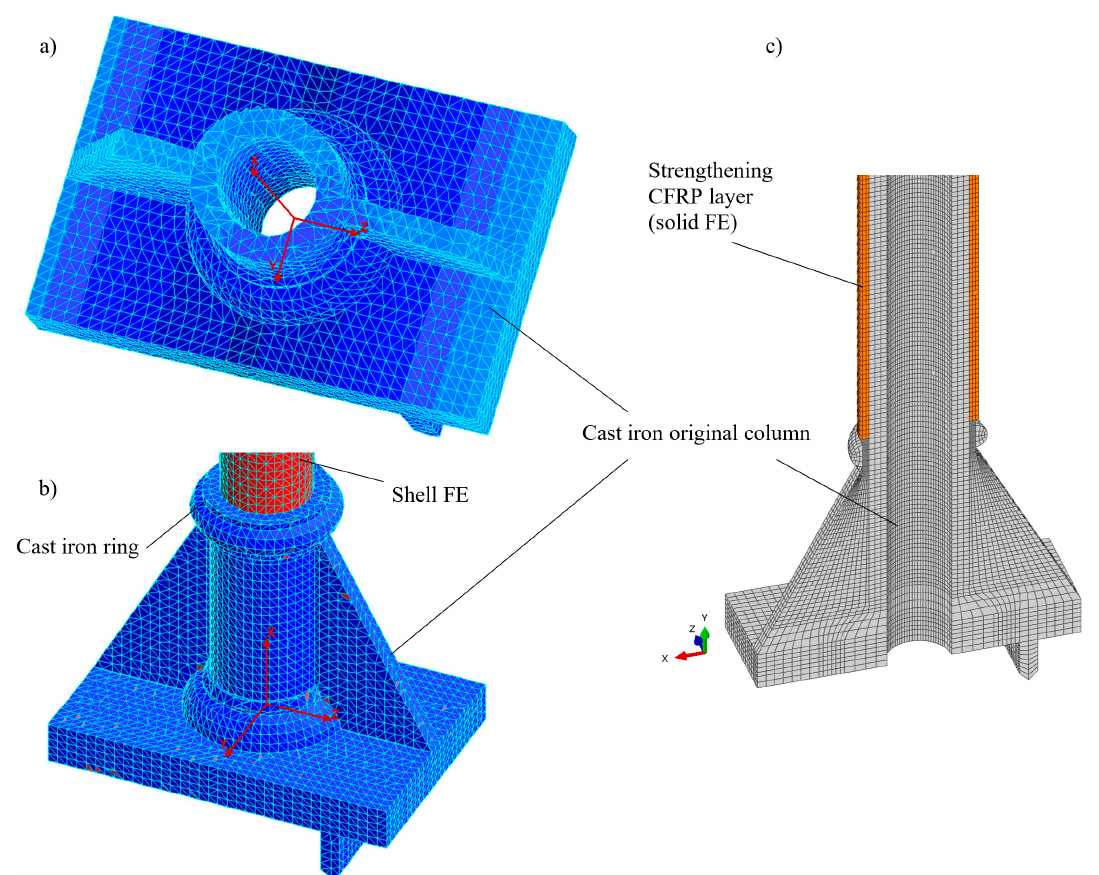
Mesh details of the cast iron column in di ff erent systems: ( a , b ) Original column base (COSMOS); ( c ) cast iron column with optional composite reinforcing covering FE (Simulia Abaqus).